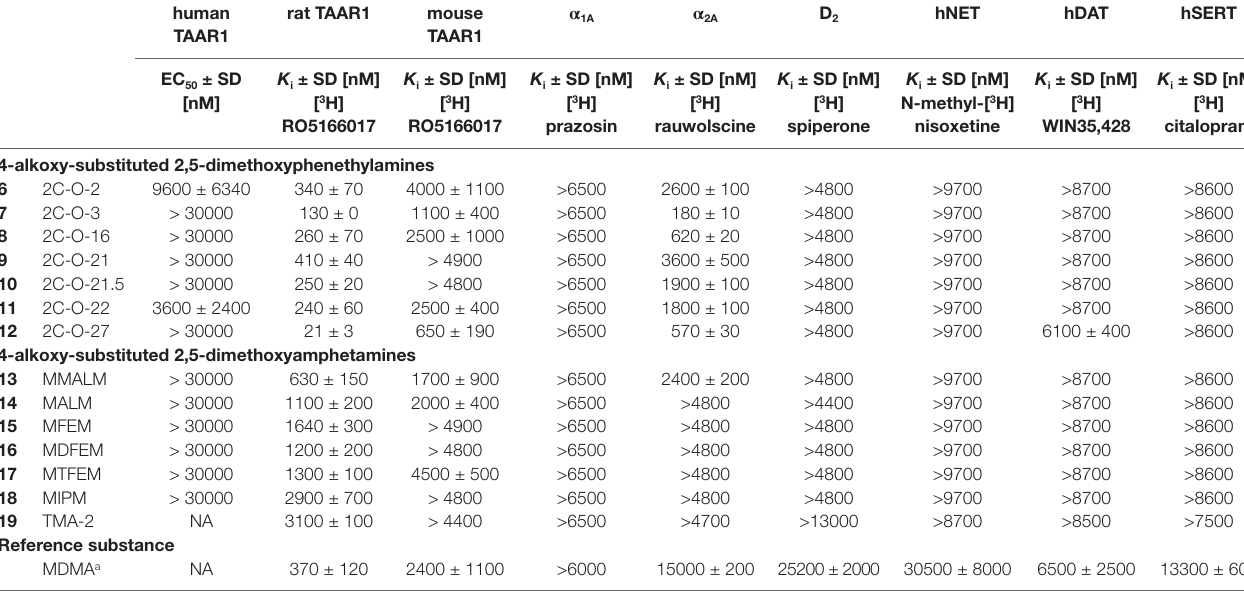
TABle 2 | Monoamine receptor and transporter binding affinities of 4-alkoxy-subsituted 2,5-dimethoxyphenethylamines and amphetamines. human